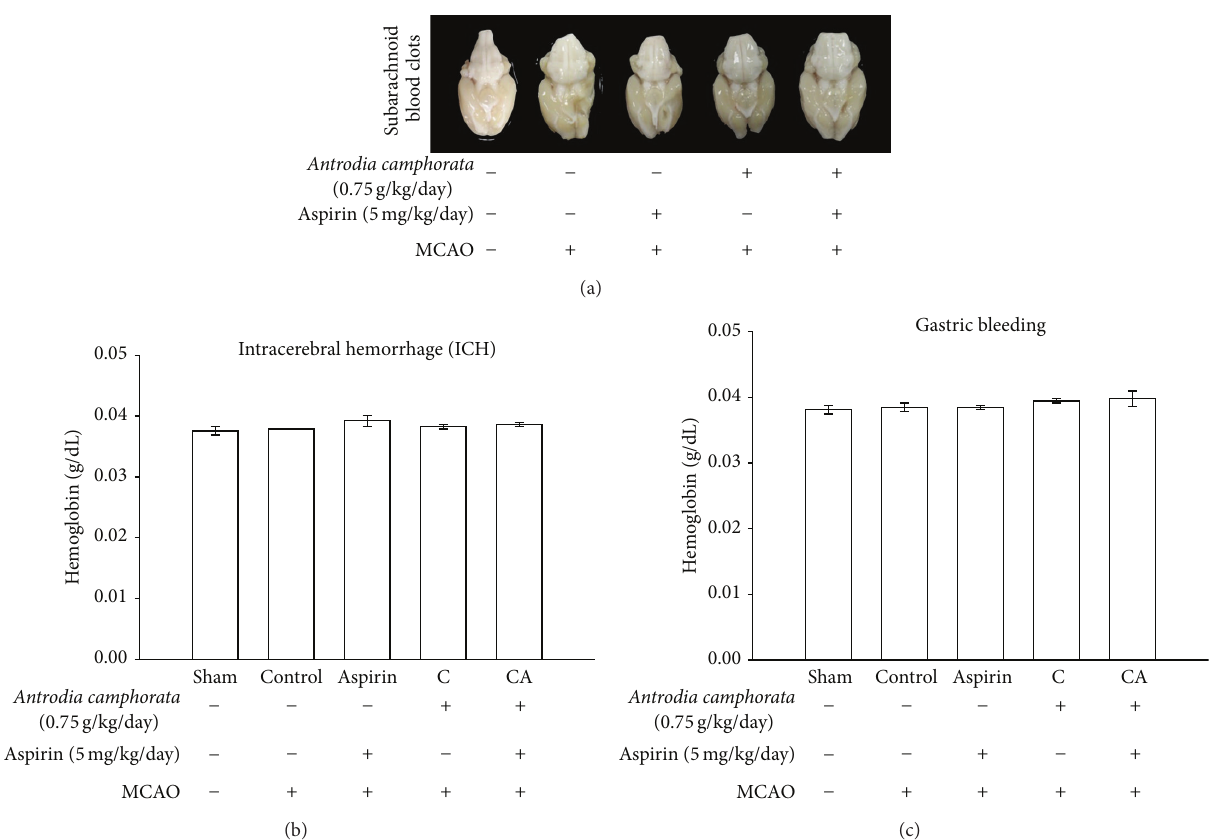
Figure 3: Effects of the extract of A. camphorata with aspirin on (a) subarachnoid hemorrhage (SAH), (b) intracerebral hemorrhage (ICH), and (c) gastric bleeding in thromboembolic stroke-induced rats. Data are presented as the means ± S.E.M. of seven similar